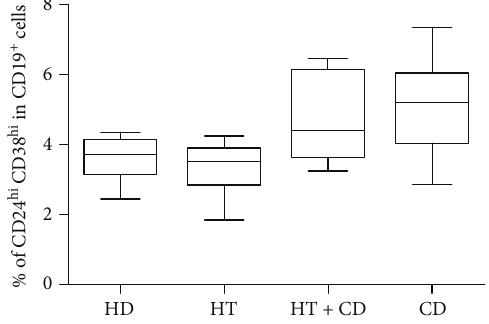
Figure 4: Stimulated IL-10 + Breg cells. Percentage of IL10 + Breg cells (CD24 hi CD38 hi IL10 + ) after CpG stimulation in healthy donors (HD), in patients with isolated Hashimoto thyroiditis (HT), in patients with Hashimoto thyroiditis plus celiac disease (HT+ CD), and in patients with celiac disease (CD). Box plots indicate median, interquartile range (box), and minimum and maximum values (whiskers). Nonparametric Kruskal-Wallis test p = 0 0159 . Dunn posttest: HT vs CD p < 0 05 . Analysis of IL- 10-producing cells was performed on the previously shown B lymphocyte subsets (CD24 hi CD38 hi